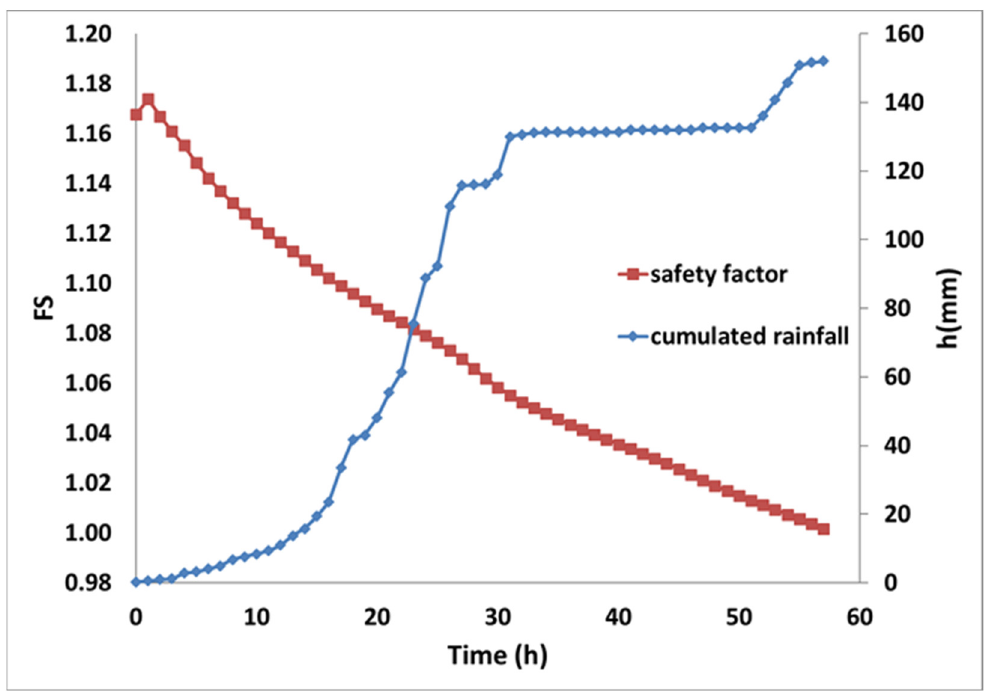
Figure 8. Variation of the safety factor for the assumed landslide body, along with the cumulated rainfall data recorded during the event.